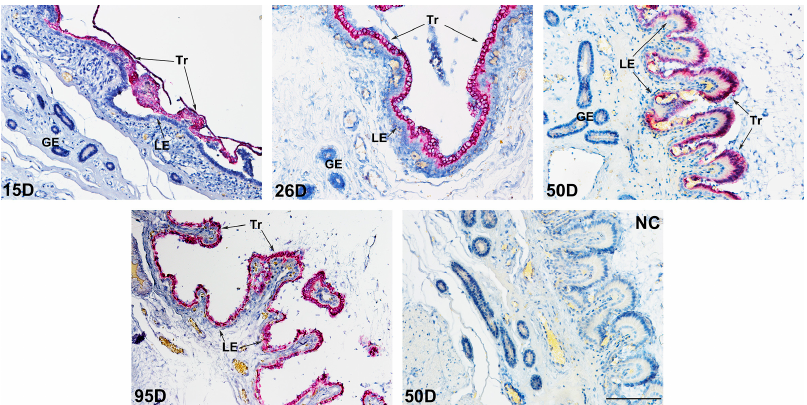
Figure 1. In situ hybridization analysis of PLET1 mRNA at the maternal-fetal interface in pigs on Days 15, 26, 50, and 95 of gestation. The PLET1 mRNA (rose-bengal) was uniquely localized to the trophoblast cells (Tr) at the maternal-fetal interface along the placental folds, and was lacking in the endometrial luminal epithelium (LE), glandular epithelium (GE), and stroma. The section stained with hybridization buffer A without probe was used as the negative control (NC). D: day of gestation. Scale bar = 100 μ m.